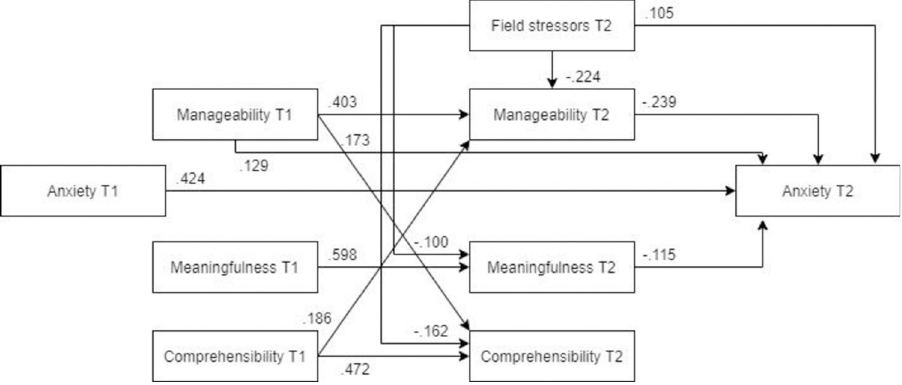
Fig 3. Optimized structural equation model for